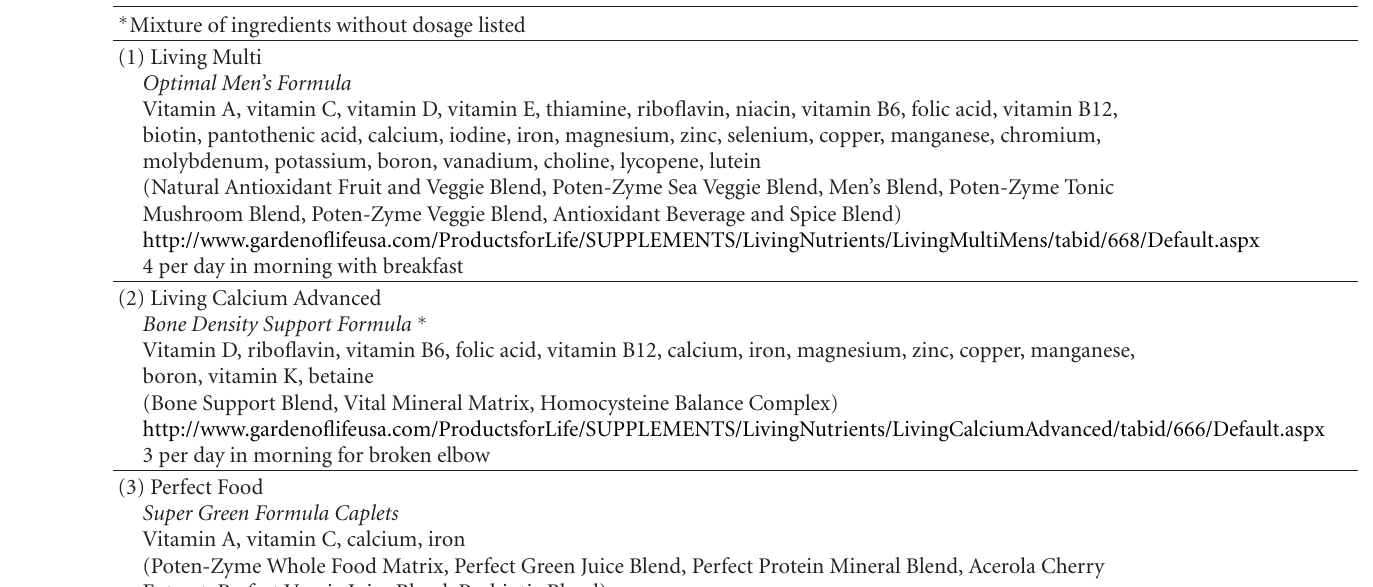
Table 1: Reported supplements in this